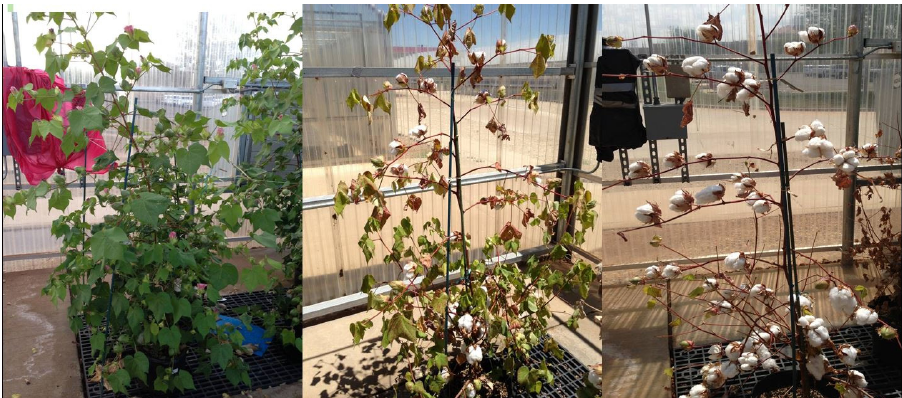
Figure 8. Cotton plant stimulation of apoptosis early programmed cell death via stem girdling. Images from left to right show how one specimen stimulated by main stem full girdling, progress from healthy through early senescence to eventual full boll opening and leaf